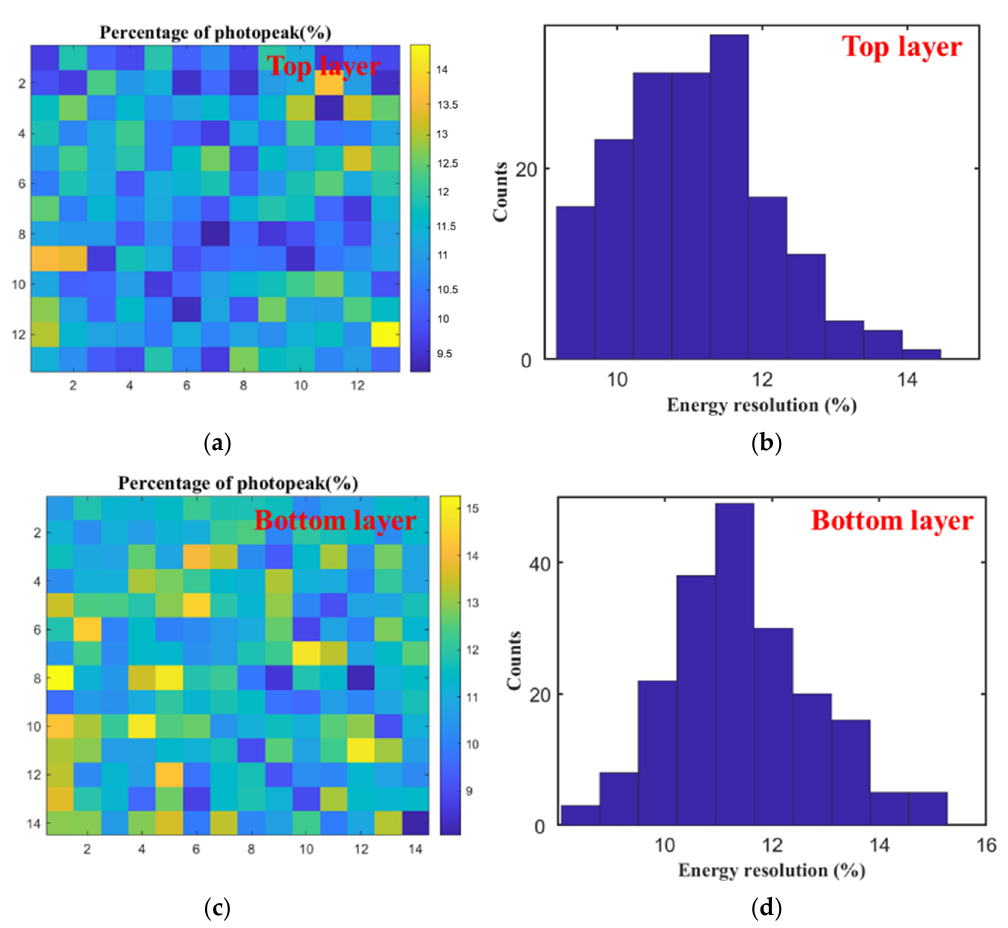
Figure 11. 2D mapping of the energy resolutions of the BaSO 4 array: ( a ) the 169 individual crystals of the 13 × 13 crystal array in the top layer and ( c ) the 196 individual crystals of the 14 × 14 crystal array in the bottom layer. The histogram of the energy resolutions of ( b ) the 169 individual crystals of the 13 × 13 crystal array in the top layer and ( d ) the 196 individual crystals of the 14 × 14 crystal array in the bottom layer.